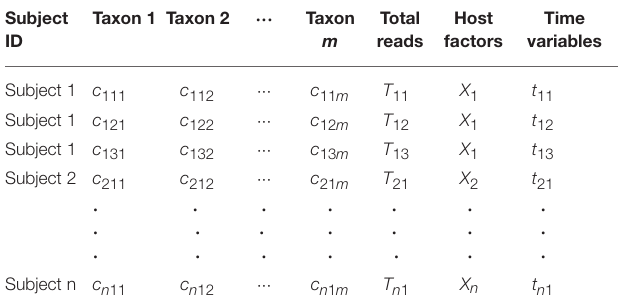
TABLE 1 | Longitudinal microbiome data